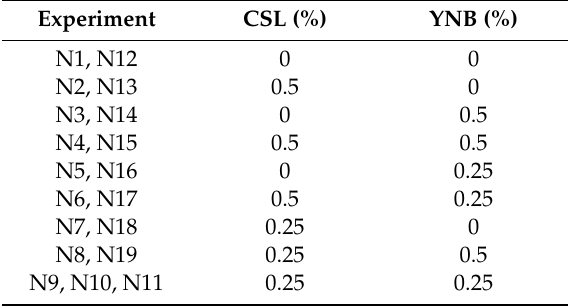
Table 3. Experimental setup combining di ff erent concentration of CSL and YNB as suggested by the model.